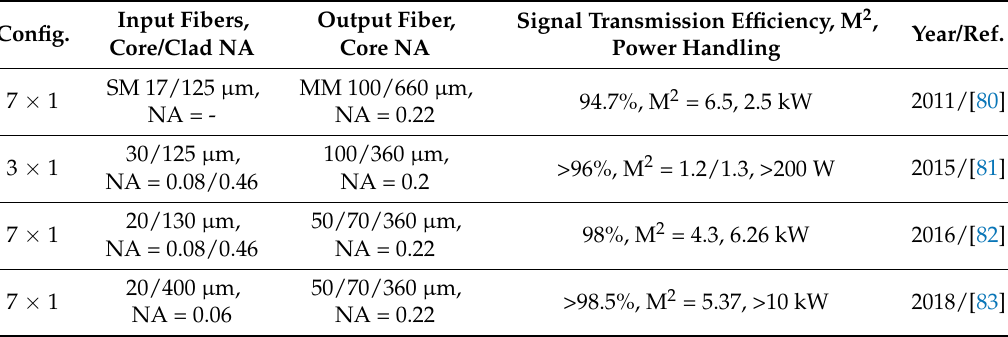
Table 3. Summary of recently reported signal power combiners